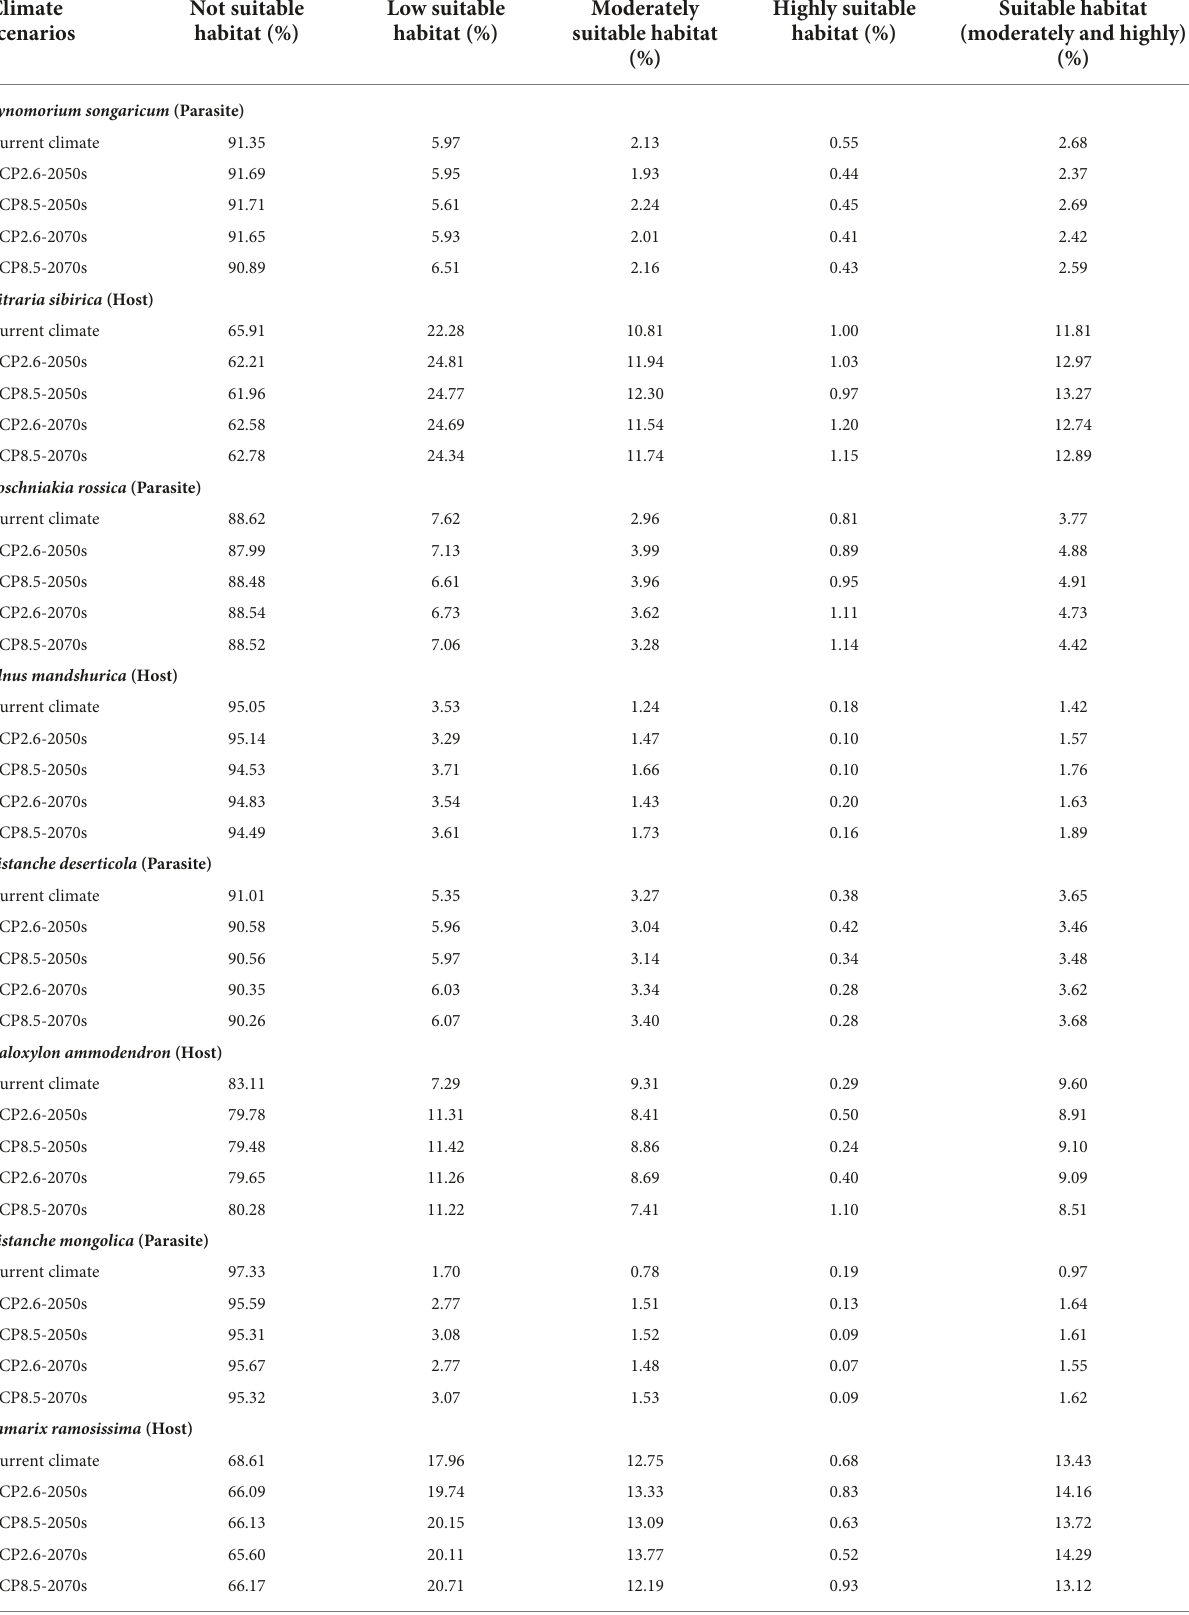
TABLE 3 Dynamics of changes in distribution area of four holoparasitic plants and their primary hosts under different climate scenarios. Climate